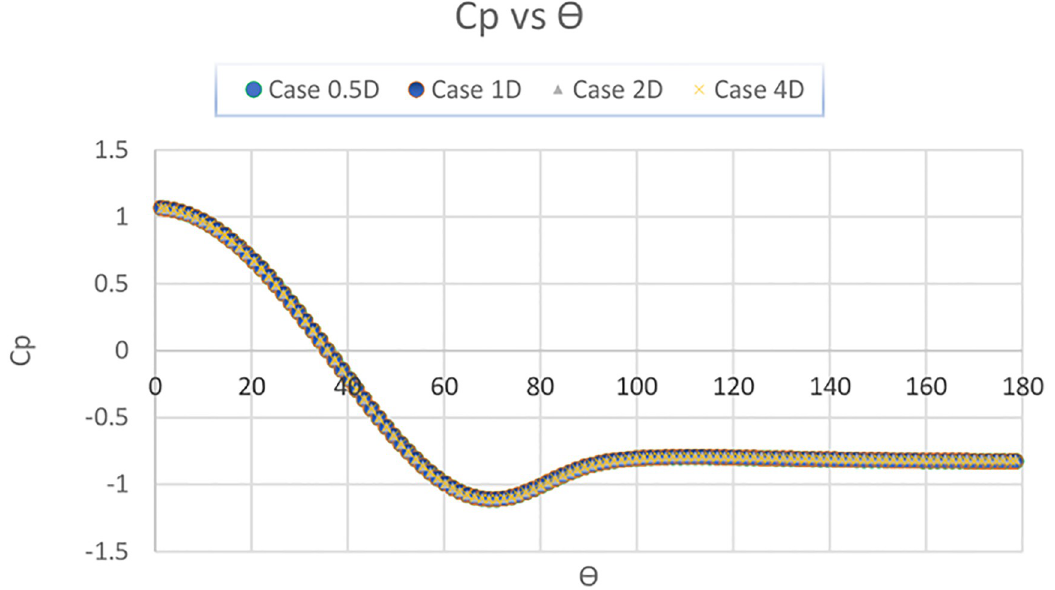
Fig 3. Coefficient of pressure (Cp) vs Angle ( ϴ